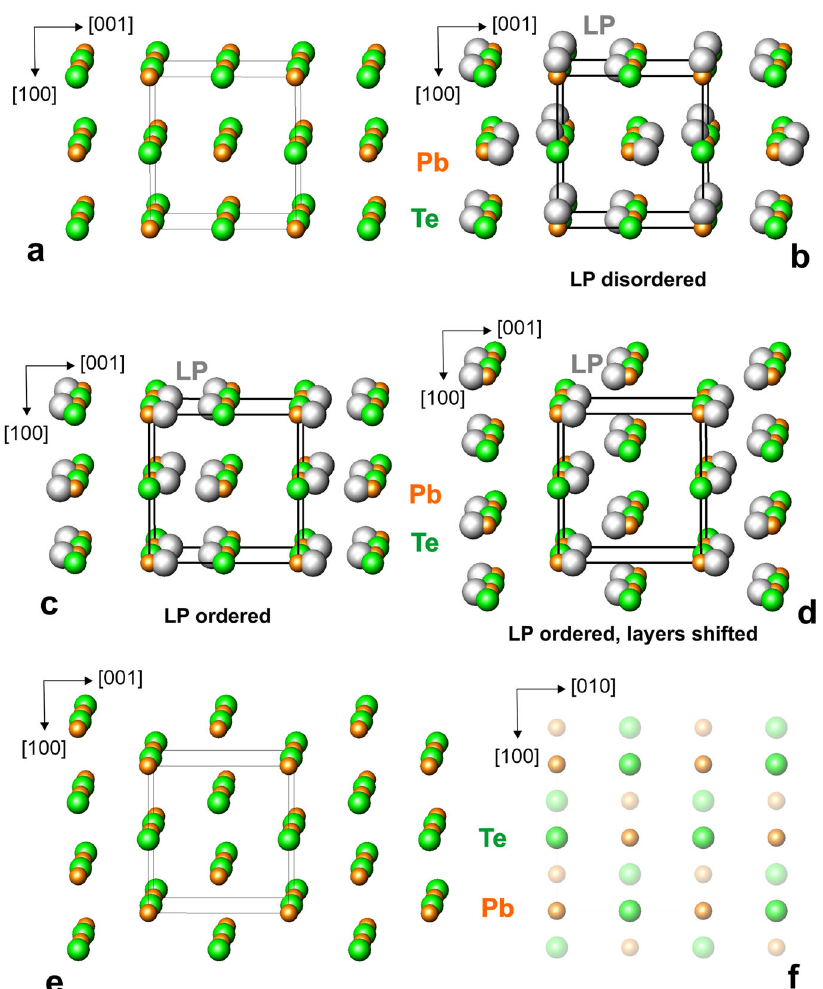
Fig. 2 Hypothetical mechanism of lone-pairs driven structural transformation in the (p-type) lead telluride single crystal. ( a ) pristine atomic arrangement in NaCl-type PbTe; ( b ) disordered lone-pairs in the pristine structure; ( c ) lone-pair ordering allowing layers shifts in the (001) plane due lone- pair repulsive interaction; ( d ) atomic arrangement with layers shifted by (0.25 0 0) reducing the repulsion between the lone-pairs; ( e , f ) the resulting atomic arrangement (cf. Fig. 1). The stoichiometry and composition in all panels is 1:1. Orange spheres – lead, green – tellurium, gray spheres symbolize lone pairs at the orange Pb atoms. The larger size of the gray spheres is used to emphasize the enhanced volume need of the lone